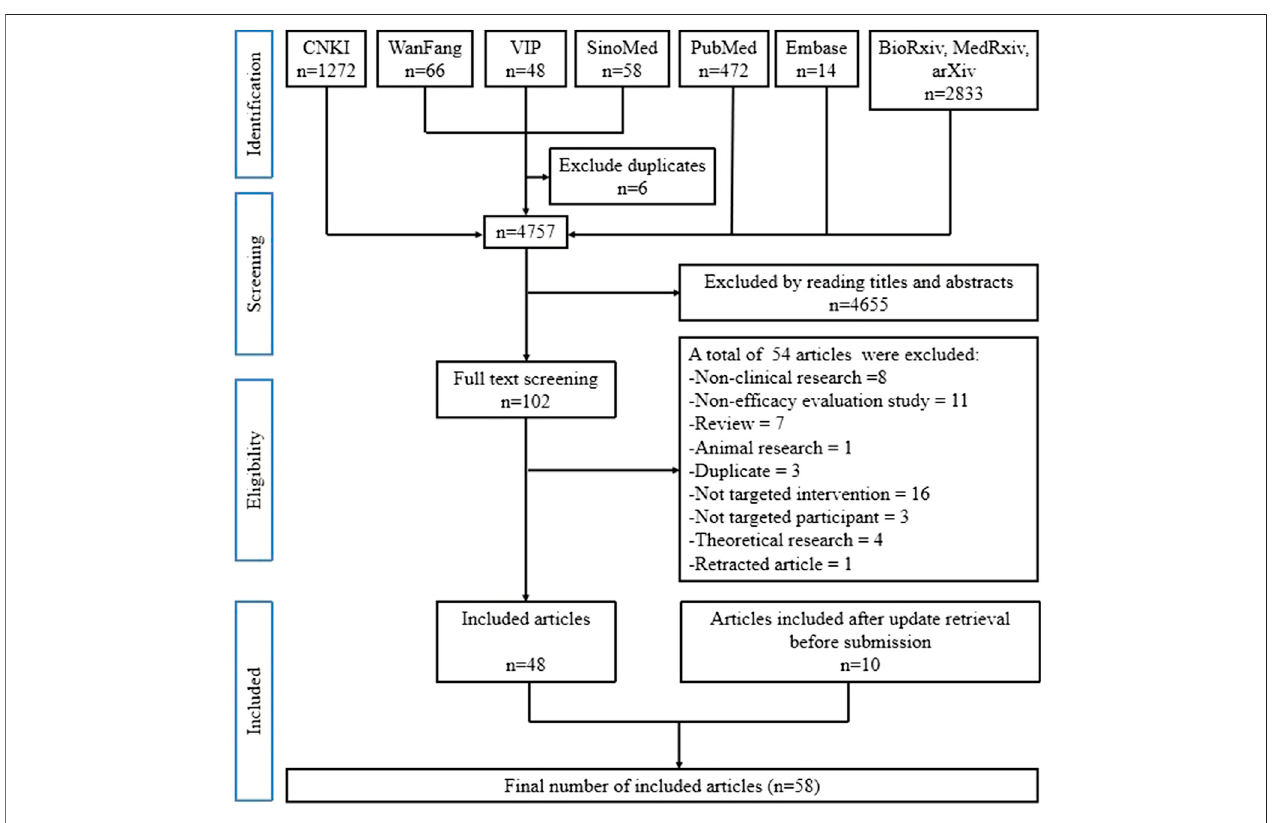
FIGURE 1 | Flow diagram for searching and screening of published